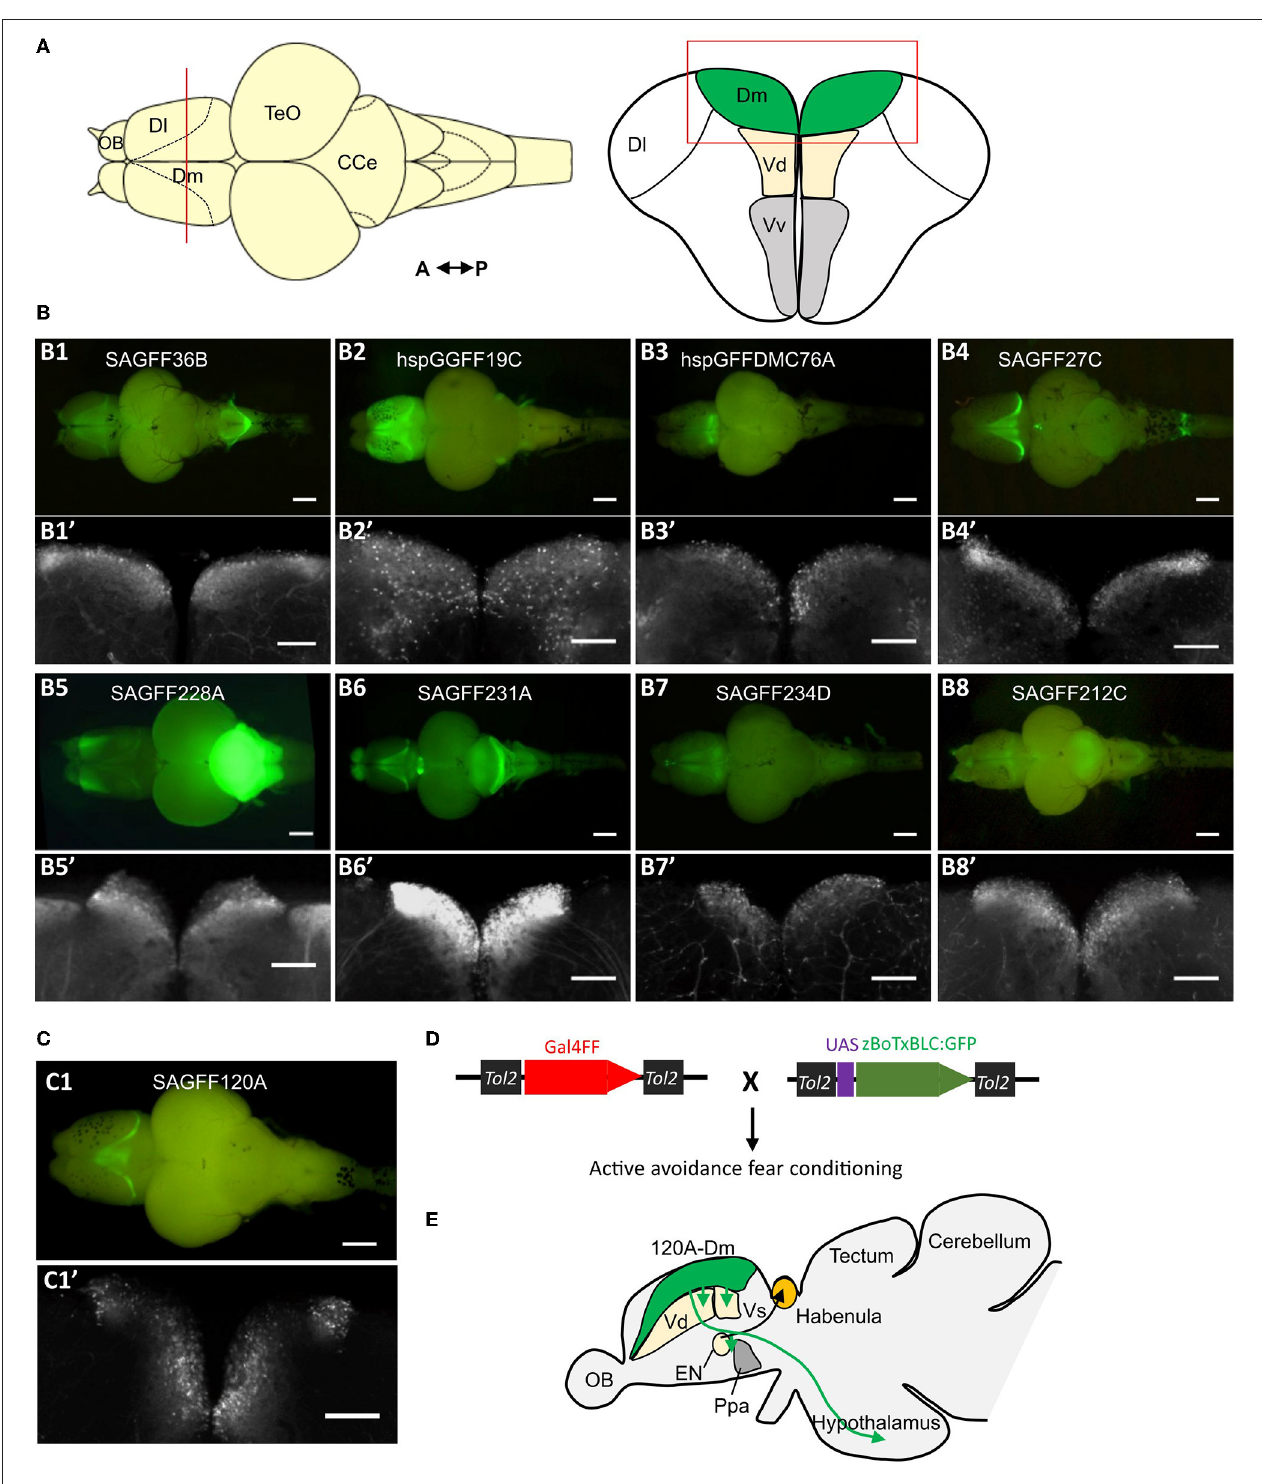
FIGURE 2 | Genetic dissection of the zebrafish amygdala. (A) Schematic of dorsal and coronal view of the zebrafish brain and telencephalon, respectively. The red line in the dorsal view shows the position of coronal section. (B) Examples of isolated brains of gene trap and enhancer trap transgenic zebrafish lines that show Gal4FF (UAS:GFP) expression in the Dm region. (B1–B8) Dorsal view of the isolated brain. Scale bar, 500 µ m. (B1’–B8’) Coronal section of the corresponding transgenic fish in (B1–B8) . The position and region of the coronal section are showed in A (red line and red box). Scale bar, 200 µ m. (C) The Gal4FF (UAS:GFP) expression pattern in the brain of transgenic fish SAGFF120A. SAGFF120A is an emx3 -enhancer trap line and labels a population of neurons in the Dm, named